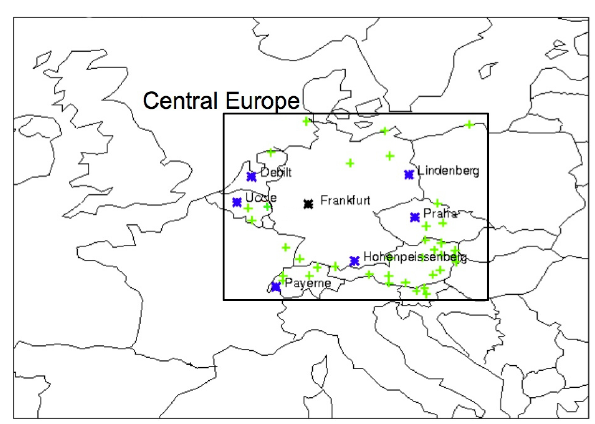
Fig. 1. Map of Europe. The Central Europe region, defined by the area between 44 ◦ N and 55 ◦ N latitude, and 3 ◦ E and 18 ◦ E longi- tude, is shown in the black rectangle. The MOZAIC city, Frankfurt, is shown with a black star, the six ozone sounding sites with blue stars and the EMEP surface stations with green plus